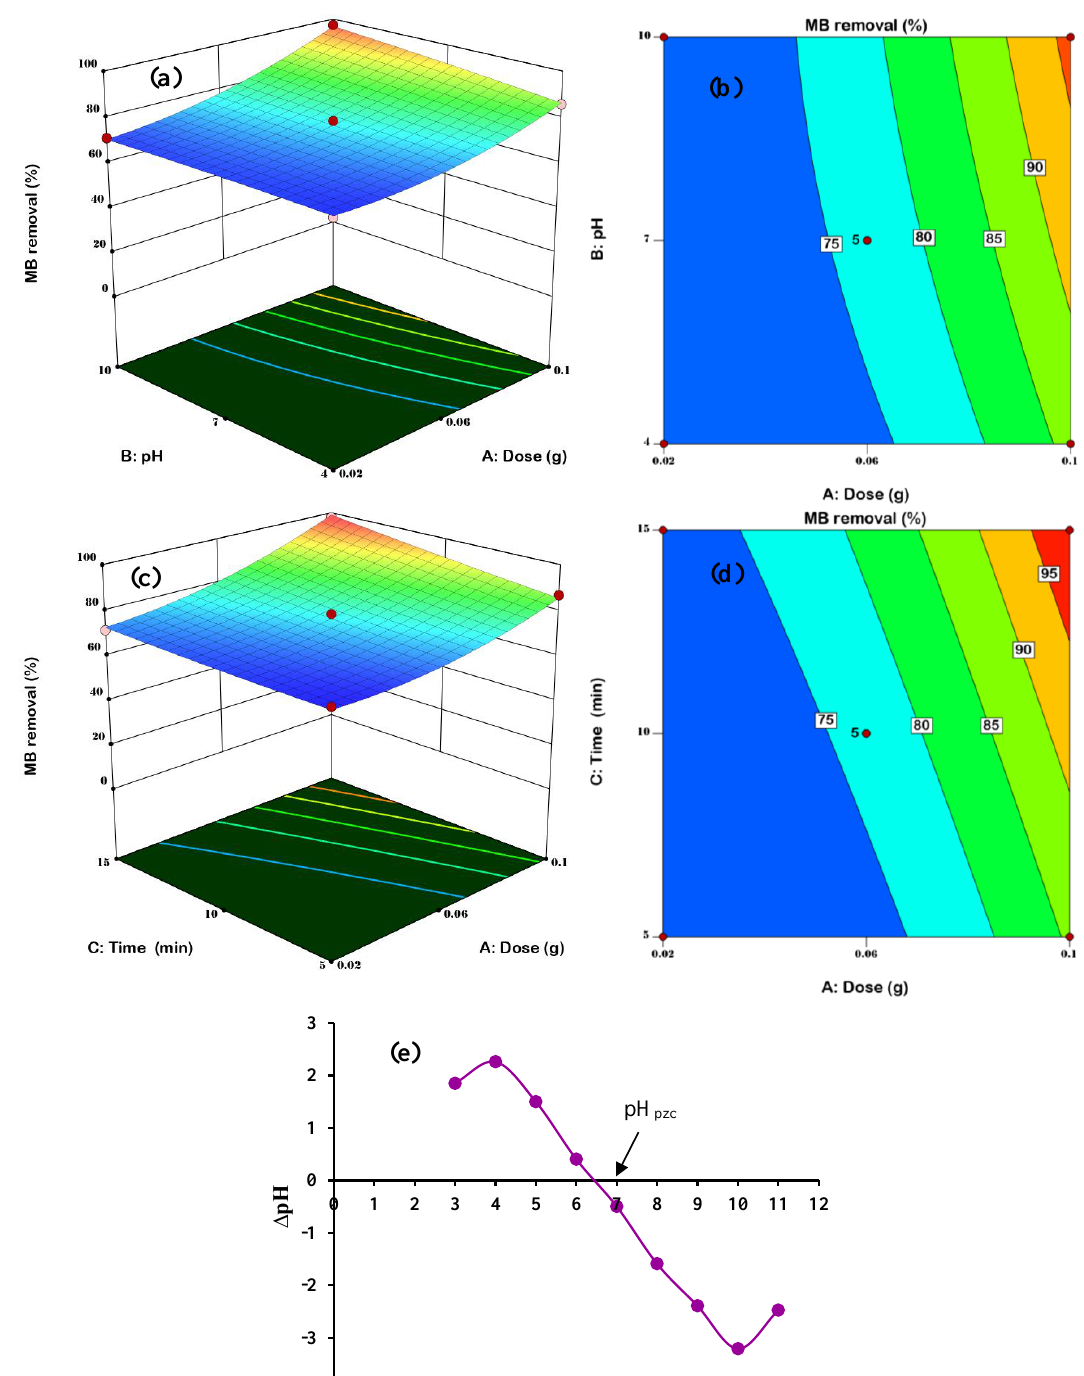
Figure 6. 3D response surfaces and 2D contour plots of AB (( a ): 3D; ( b ): 2D) and AC (( c ): 3D; ( d ): 2D) interactions; while ( e ) pHpzc of